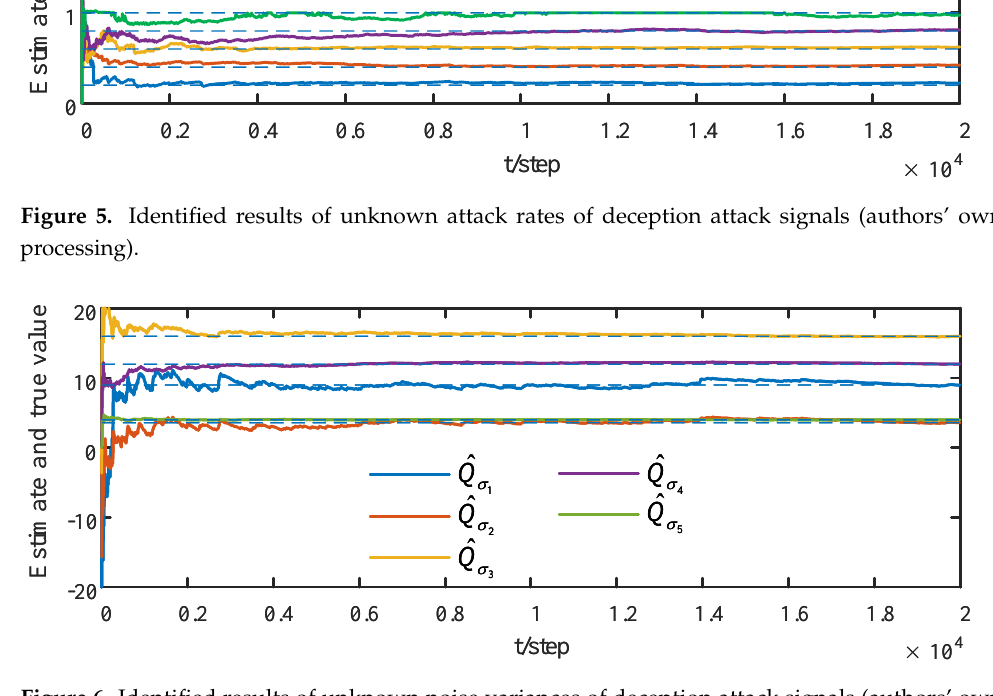
Figure 6. Identified results of unknown noise variances of deception attack signals (authors’ own processing).